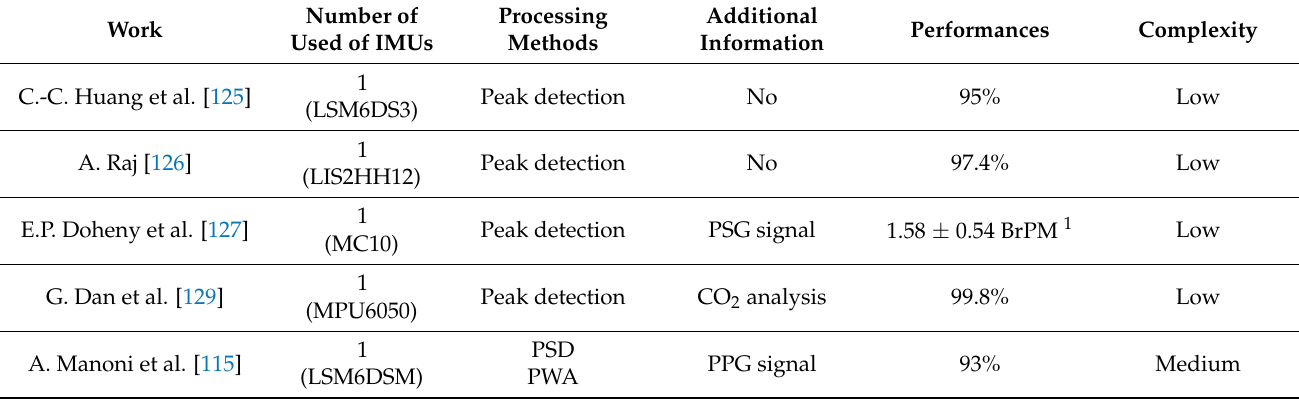
Table 5. Comparative table of the scientific works related to innovative algorithms for monitoring the respiratory activity from the inertial